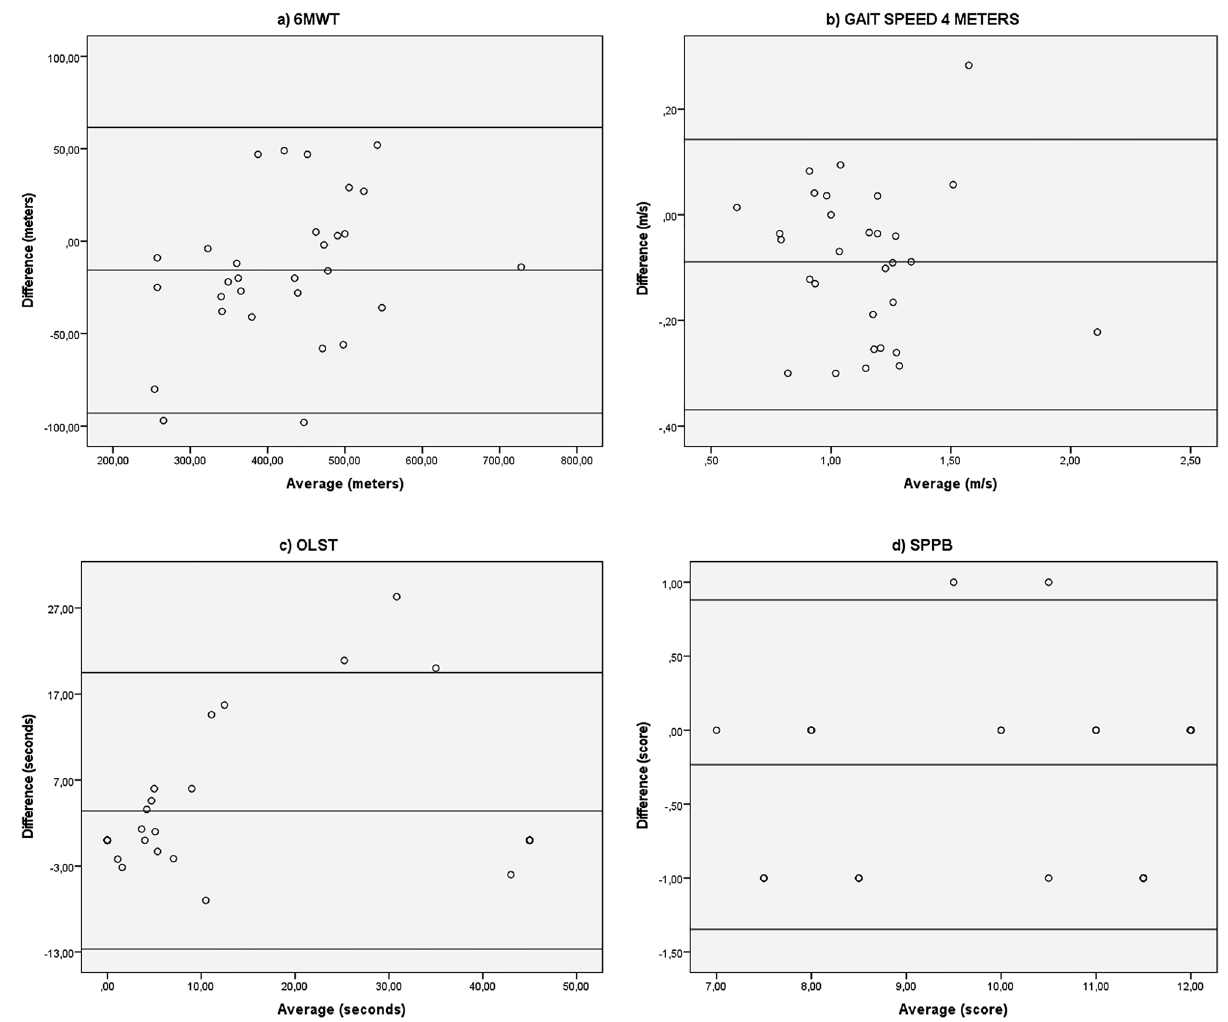
Figure 6. Bland–Altman plots for the tests that showed systematic bias: 6 min walk test; gait speed in 4 m; one- leg stand test; short physical performance